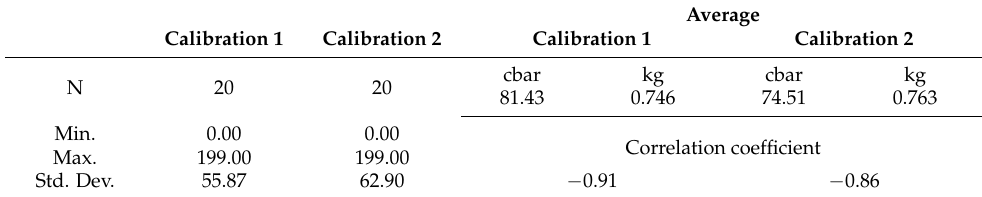
Table 3. Granular matrix sensors’ (GMSs’) calibration results.